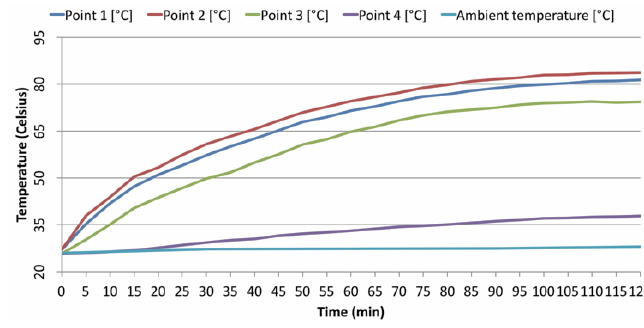
Figure 14. Temperature test, only stator mounted in the shaft, 2 A dc current to the winding.